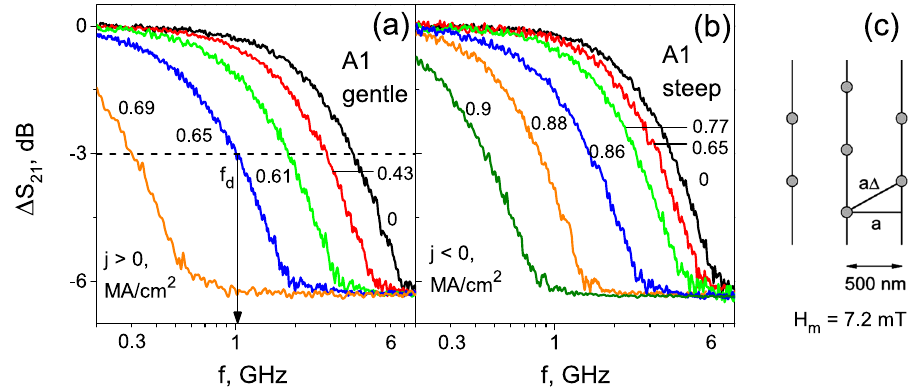
Figure 2. Frequency dependence of the relative change of the absolute value of the forward transmission coefficient Δ S 21 ( f ) of sample A1 at positive ( a ) and negative ( b ) dc densities, as indicated. The arrow in ( a ) indicates the definition of the depinning frequency f d by the − 3 dB criterion. ( c ) Vortex lattice configuration 1/2 and the matching condition = with lattice parameter = Φ ∆ a H (2 / 3) ∆ 0